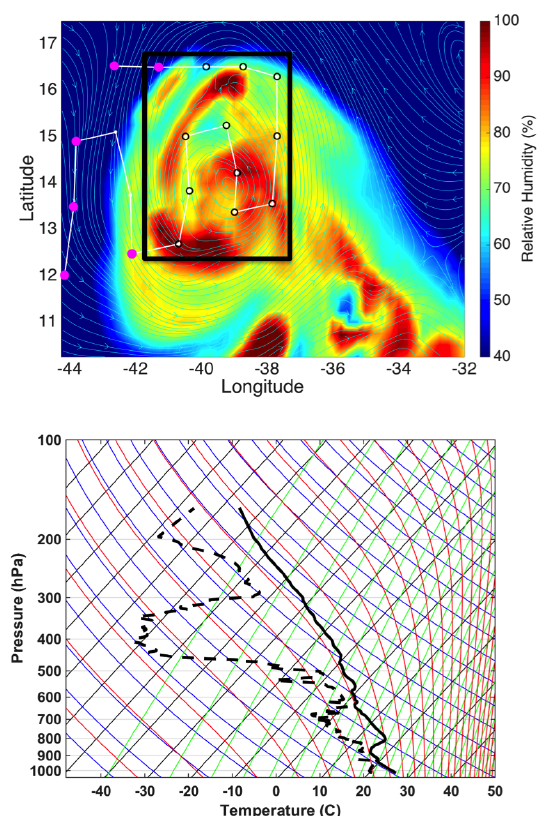
Figure 10. PREDICT flight path (white line) and dropsonde lo- cations (dots) overlaid on 700hPa relative humidity (shading) and co-moving streamlines (cyan lines) from ECMWF analysis data at 18:00UTC 2 September (top panel). The magenta dots indicate lo- cations where dropsonde data show evidence of an inversion. The black box corresponds to GR14 Fig. 8. Only one of the 12 sound- ings in the GR14 area of interest shows evidence of an inversion (bottom panel).